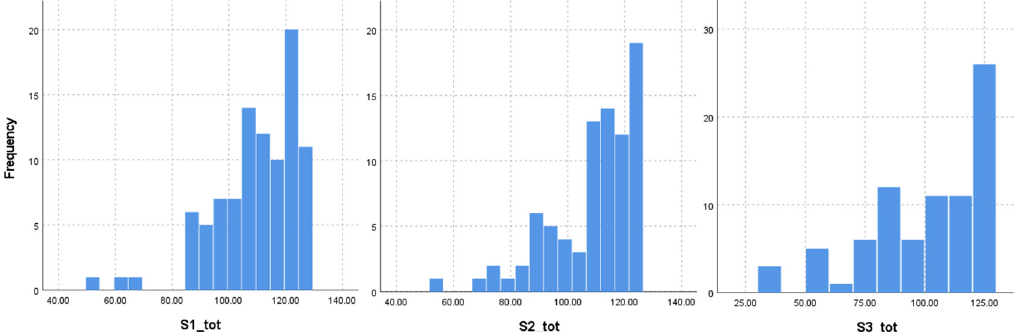
Figure 2. Standardized residual normality for Scenarios 1–3.